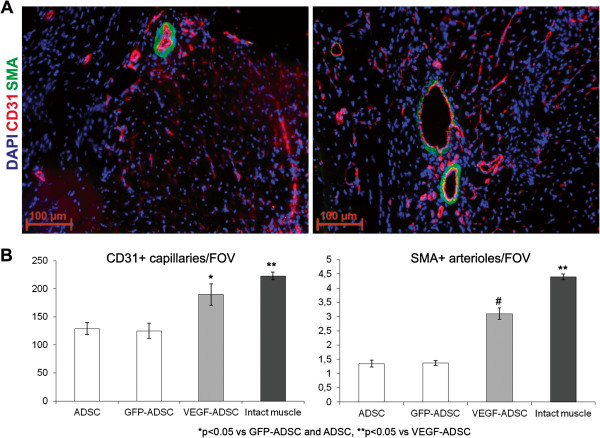
Vascularization of murine ischemic muscles after ADSC administration. A. Representative images of m. tibialis anterior sections from “VEGF-ADSC” and “ADSC” groups stained by antibodies against murine CD31 and SMA, 100× magnification. B. Capillaries and arterioles count in m. tibialis anterior sections. Counts made in 5–6 animals per group.